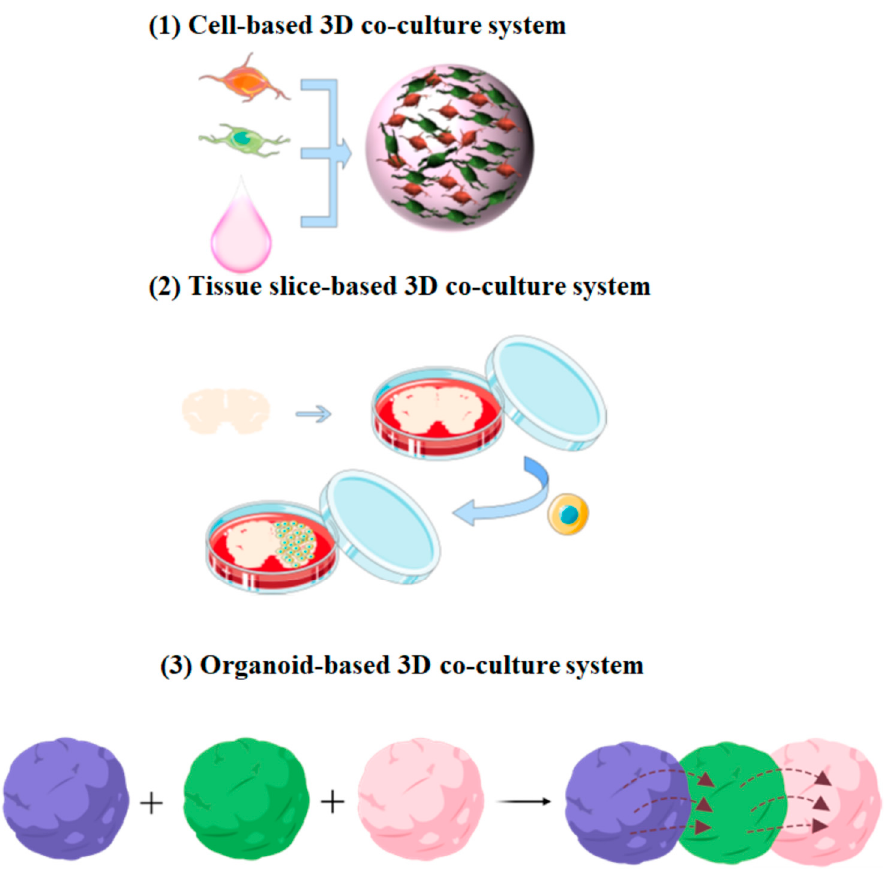
Figure 2. Application of 3D co-culture models in the study of neural cell interactions: ( 1 ) Different types of neural cells can be encapsulated into hydrogels that have a certain 3D structure after gelatinization. ( 2 ) Cells can be co-cultured with an organotypic slice which preserves the major advantages of in vitro system. ( 3 ) The organoid-based co-culture system can be developed to study the disease processes involving multiple systems or tissues.